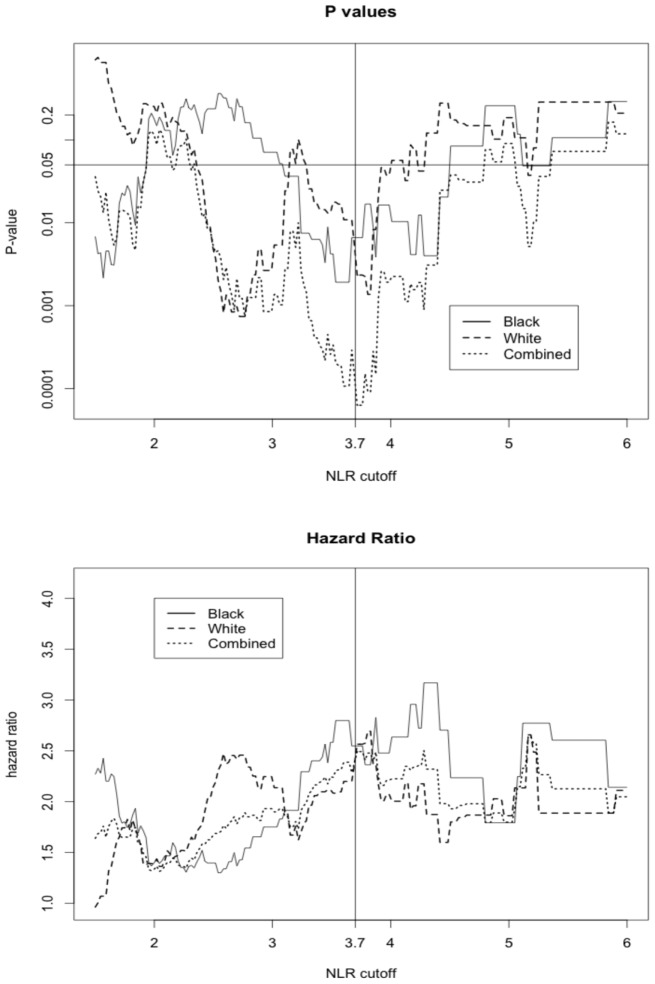
The hazard ratio and p-value for all-cause mortality in patients above or equal versus below the corresponding NLR cutoff displayed on x-axis.